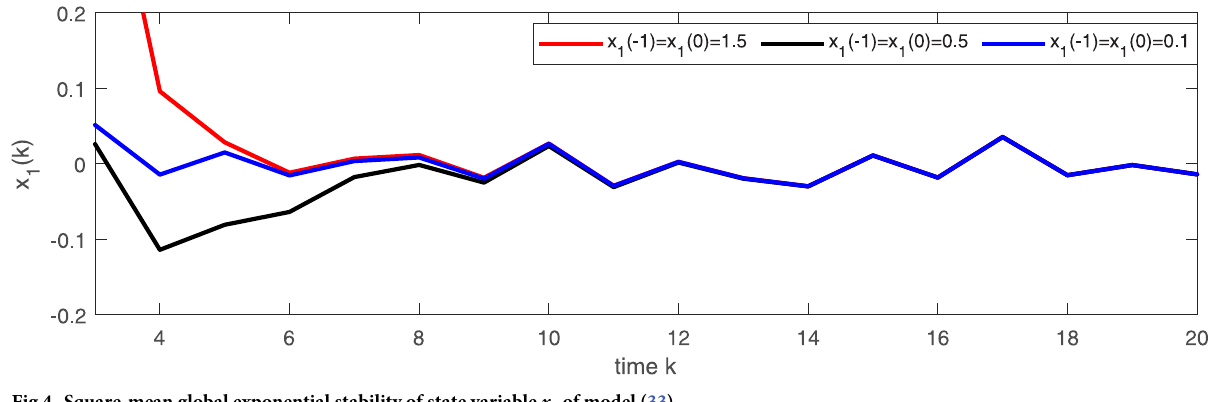
Fig 4. Square-mean global exponential stability of state variable x 1 of model